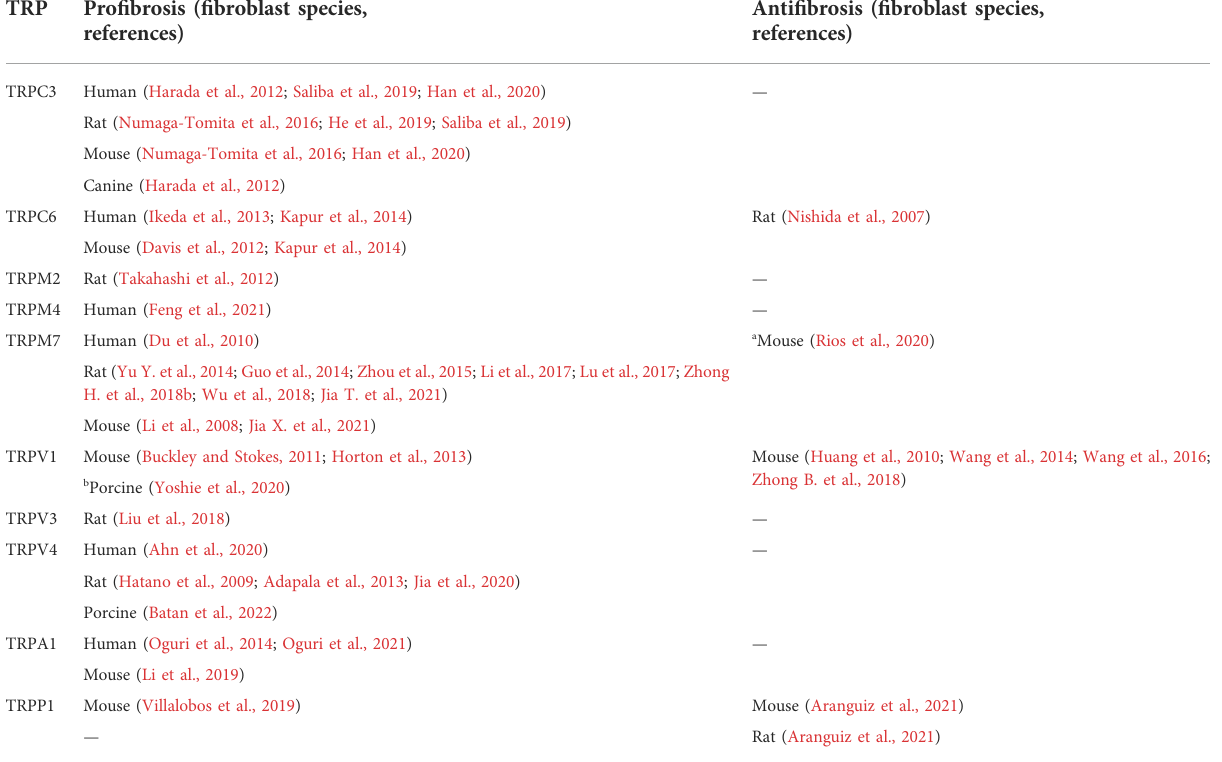
TABLE 1 Pro fi brotic and anti fi brotic effects of TRP channels in cardiac fi broblasts. TRP Pro fi brosis ( fi broblast species, references)